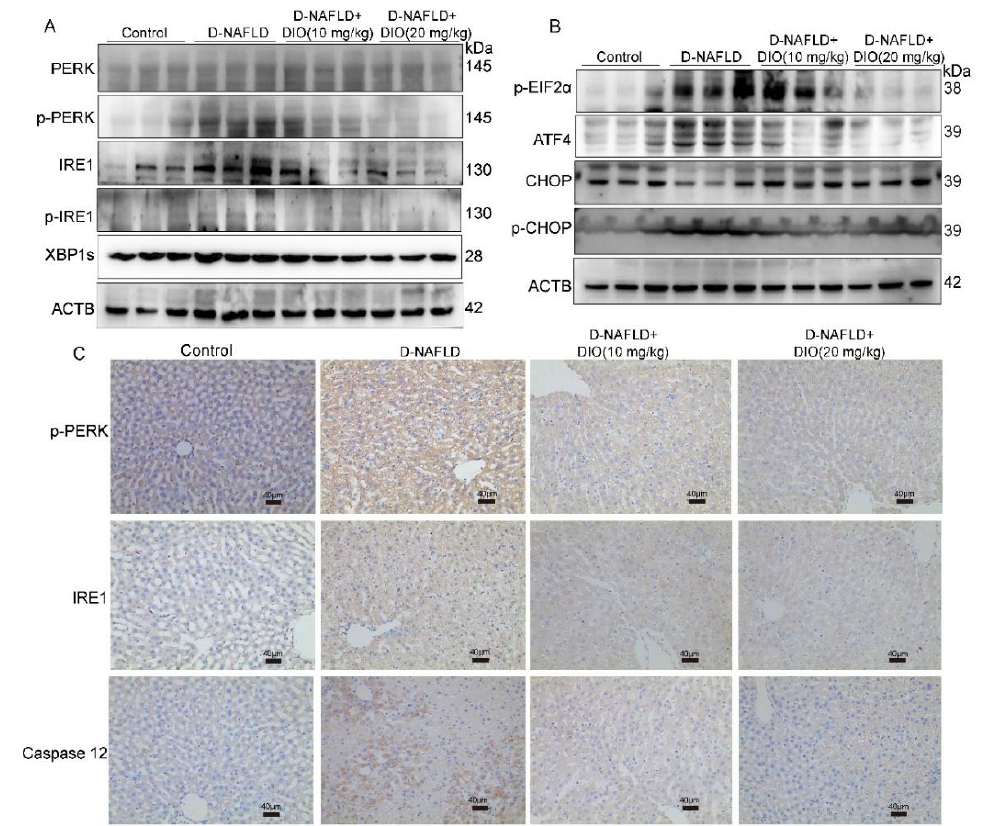
Figure 5. DIO ameliorated ER stress and associated apoptosis in the liver of D-NAFLD rats. ( A ) Western blot images of PERK, p-PERK, IRE1, p-IRE1, XBP1s, and ACTB. ( B ) Western blot images of p- EIF2α, ATF4, CHOP, p -CHOP, and ACTB. ( C ) The images of p-PERK, IRE1, and caspase 12 im- munohistochemistry, ×100, scale bars = 40